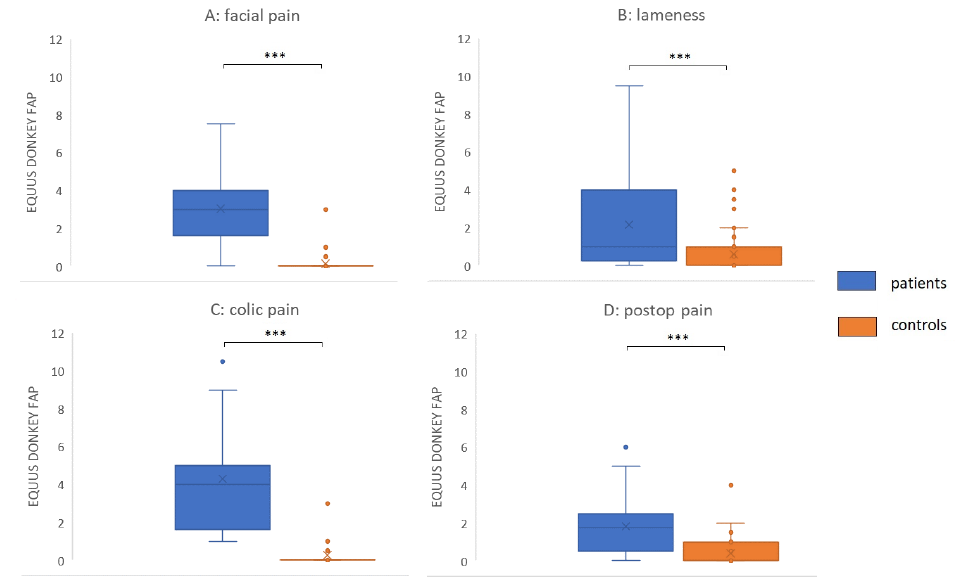
Figure 4. EQUUS-DONKEY-FAP patients versus controls. (A ) Facial pain ( n = 18 patients versus n = 39 controls), ( B ) Orthopaedic pain ( n = 25 patients versus n = 68 controls); ( C ) Colic pain ( n = 12 patients versus n = 28 controls), ( D ) Postoperative pain ( n = 24 patients versus n = 50 controls). Lines in boxes show median scores; x—mean value; boxes show 25th–75th percentiles; error bars show 5th–95th percentiles. *** — p < 0.001.